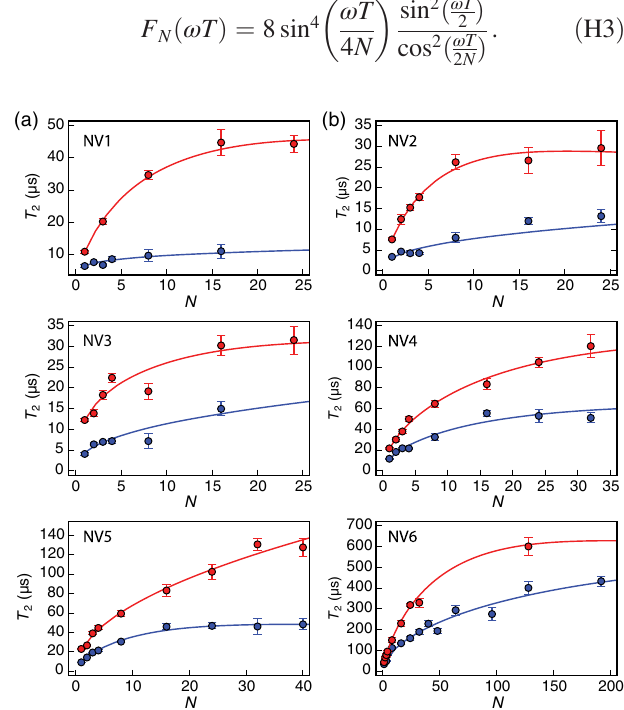
FIG. 10. Coherence time as a function of number of dynamical decoupling pulses N for all six NV centers presented in the main text for triacid-cleaned (blue) and oxygen-annealed (red) surfa- ces. The fit parameters are shown in Table